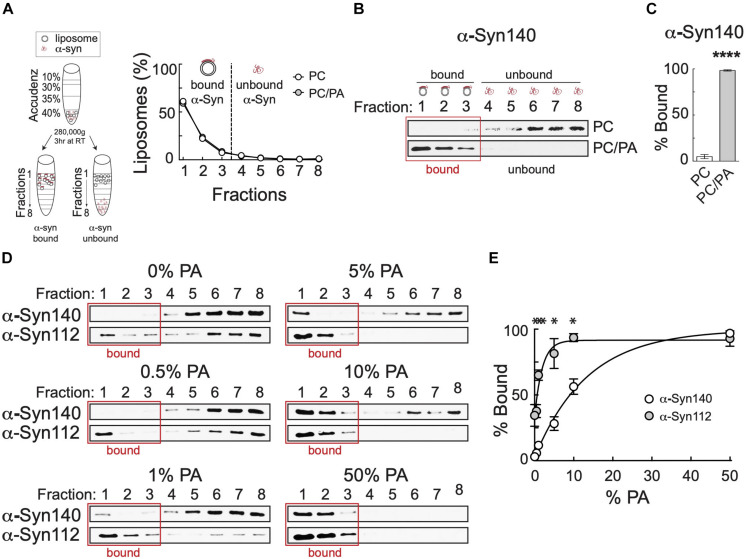
Compared to α-syn140, α-syn-112 exhibits enhanced binding to PC/PA liposomes. (A) (left) Diagram showing the liposome binding assay. (right) After ultracentrifugation, liposomes float to the top of the gradient (fractions 1–3), carrying along any bound α-synuclein while free α-synuclein remains in the bottom fractions (4–8). (B) Representative Western blots showing α-syn-140 binding to PC or PC/PA liposomes. α-Syn-140 binds strongly to anionic phospholipids such as PA. (C) Quantification of lipid bound α-syn-140 in the presence of PC or PC/PA liposomes. Bars indicate mean ± SEM from n = 3 to 4 independent experiments.*p < 0.0001; Student’s t-test. (D) Representative Western blots showing α-syn-140 and α-syn-112 binding to liposomes containing varying amounts of PA. Red box indicates liposome-containing fractions. α-Syn112 exhibited enhanced binding to PC/PA liposomes. (E) Quantification of lipid bound protein (0% PA = α-syn-140: 3.03 ± 1.86, n = 3; α-syn-112: 34.42 ± 8.28, n = 3; p < 0.001) (0.5% PA = α-syn-140: 5.76 ± 1.89, n = 4; α-syn-112: 37.697 ± 4.95, n = 3; p < 0.001) (1% PA = α-syn-140: 11.74 ± 0.93, n = 3; α-syn-112: 65.08 ± 3.98, n = 3; p < 0.0001) (5% PA = α-syn-140: 28.21 ± 5.14, n = 4; α-syn-112: 81.46 ± 11.32, n = 3; p < 0.0001) (10% PA = α-syn-140: 56.31 ± 5.85, n = 4; α-syn-112: 93.53 ± 3.02, n = 3; p = 0.0002) (50% PA = α-syn-140: 96.70 ± 0.00, n = 3; α-syn-112: 92.67 ± 5.87, n = 3; p = 0.54). Data points indicate mean ± SEM. Asterisks indicate statistical significance using ANOVA (Sidak’s post hoc). *p < 0.001. Data were best fit by a non-linear dose-response curve (R2(Syn140) = 0.96; R2(Syn112) = 0.84).